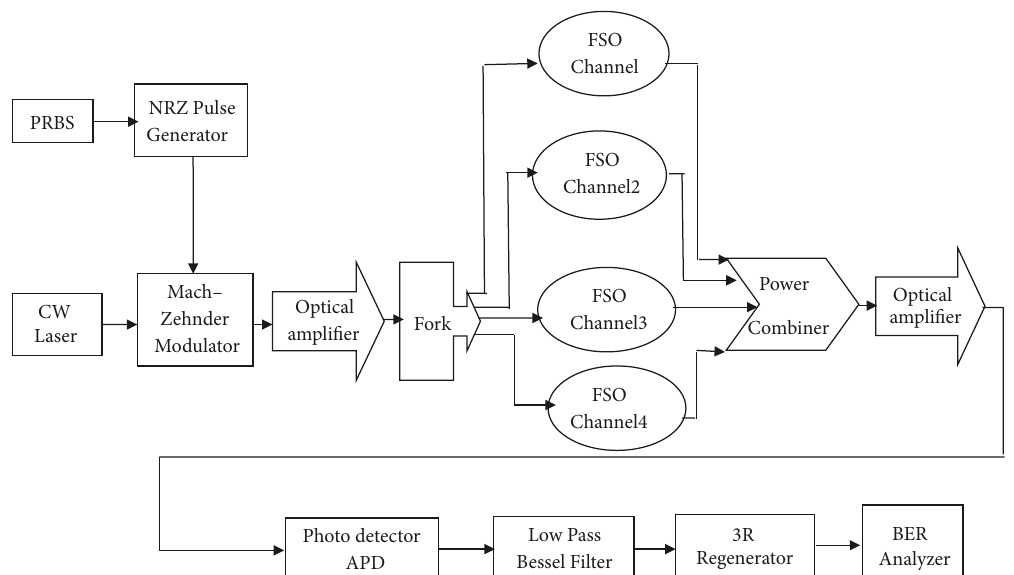
Figure 4: Simulation layout of (4 T X /4 R X ) FSO system.